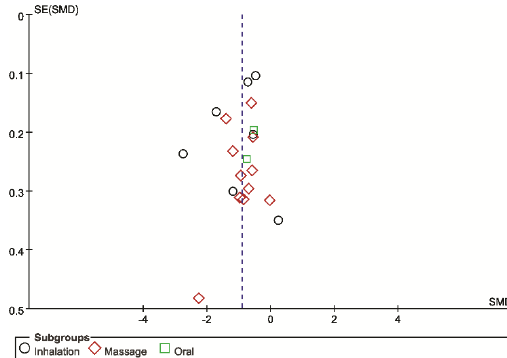
Figure 4. Funnel plot for aromatherapies for pain management compared with placebo